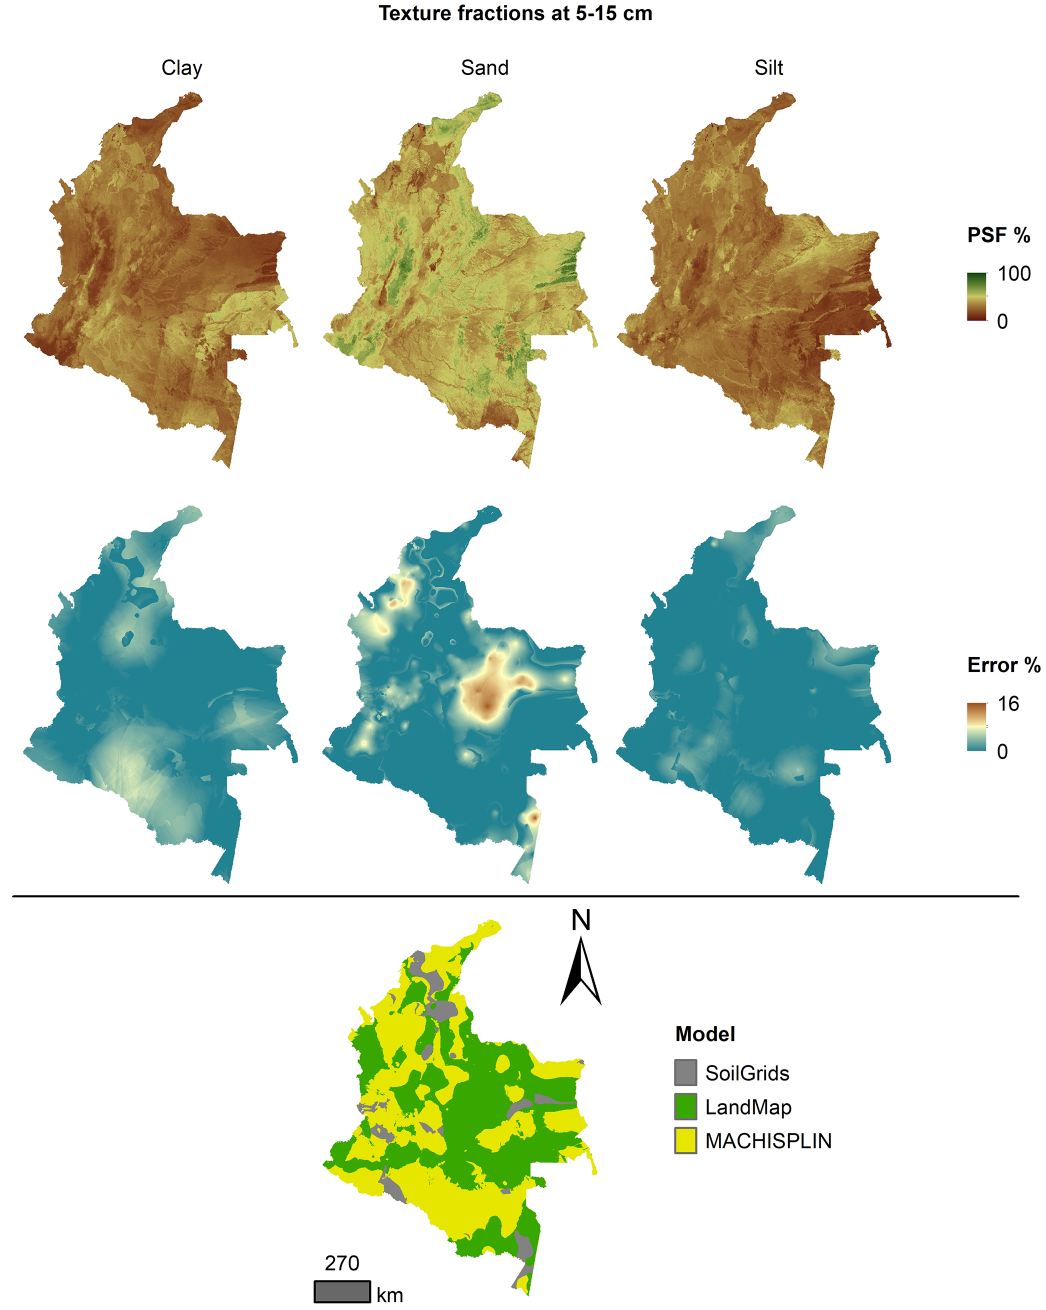
Figure 6. Ensemble model, percentage error distribution, and best model selected at